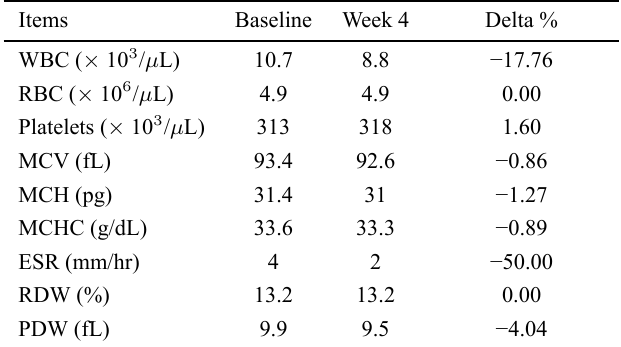
Table 2. Changes of complete blood